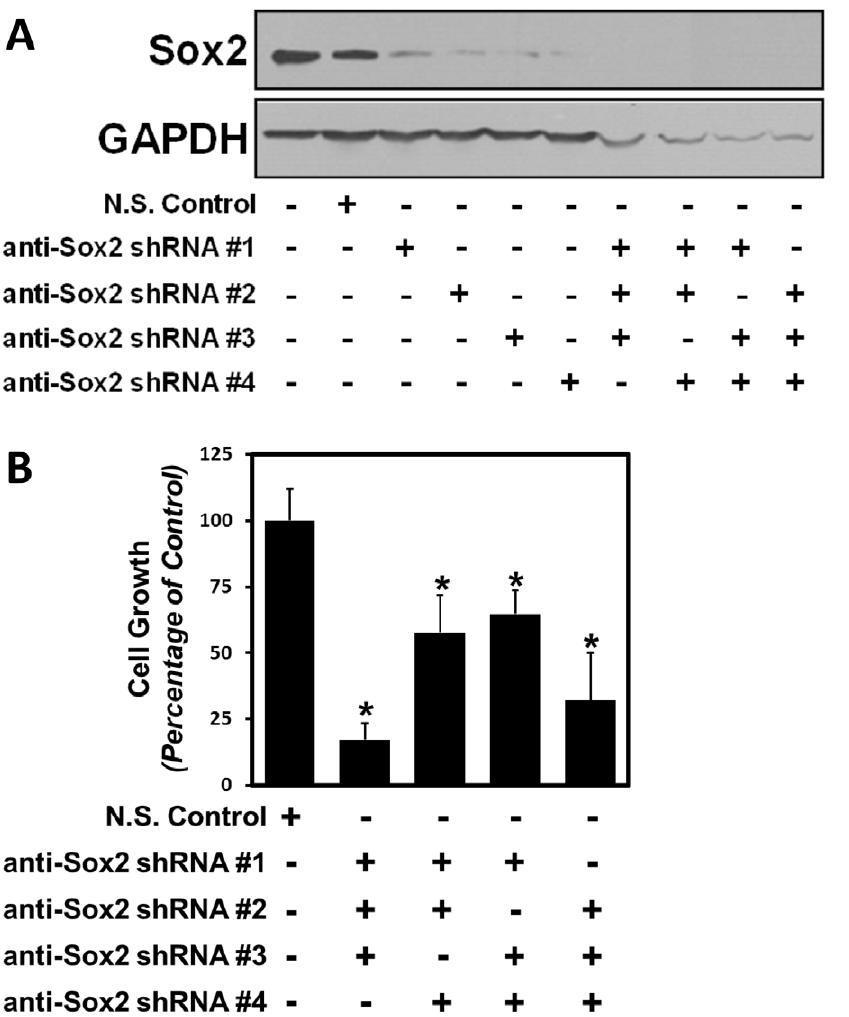
Figure 8. Sox2 expression is necessary for the growth of castration-resistant prostate cancer cells. A ) Depletion of Sox2 protein expression using four different lentiviral shRNA constructs. To test the impact of inhibiting Sox2 expression in castration-resistant CWR-R1 cells, we used a series of shRNAs that targeted different regions of the Sox2 mRNA transcript. These data show that each shRNA sequence results in decreased Sox2 protein expression after 72 hours, and combinations of three were used to obtain levels below detection while controlling for potential off- target (i.e. non-Sox2 specific) effects. A non-silencing shRNA (NSC) control was used in comparison. GAPDH was used as a loading control. B ) Decreased expression of Sox2 results in significant growth inhibition. Cell growth was measured using MTT reduction after five days in complete media. In all four instances of Sox2 knockdown, cell growth was significantly diminished compared to the non-silencing control.